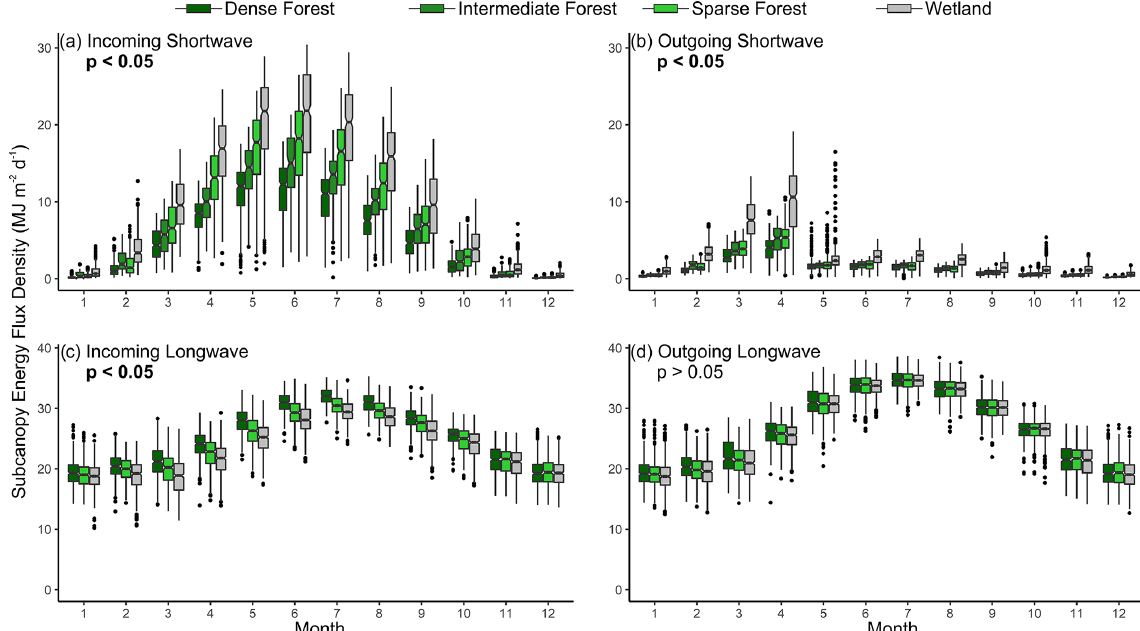
Figure 7. Subcanopy daily total (megajoules per square metre per day) incoming shortwave (a) , outgoing shortwave (b) , incoming longwave (c) , and outgoing longwave (d) at the four meteorological stations. Each station represents a distinct land cover, i.e. dense forest (2007– 2019), intermediate forest (2014–2019), sparse forest (2015–2018), and treeless wetland (2004–2019). The boxes represent the 25th and 75th percentile, while the whiskers represent the range of the data. The notches on each box indicate the confidence interval ( a = 0 . 05) around the mean, while the statistical differences between meteorological stations have been presented in the upper left of each plot as determined by one-way ANOVA. Significant p values have been highlighted with bold